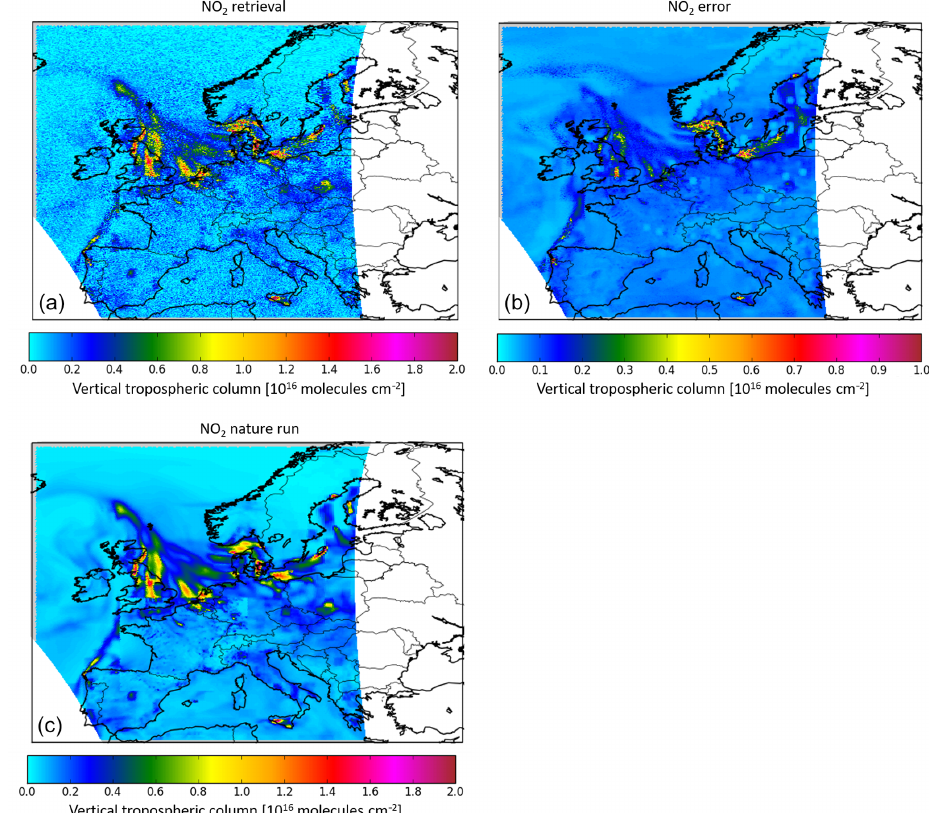
Figure 3. Example of the S5P synthetic retrieval of the NO 2 tropospheric column on 1 June 2003. The plots show the retrieved noisy NO 2 column (a) , the associated retrieval error (b) and the NR result (c) .